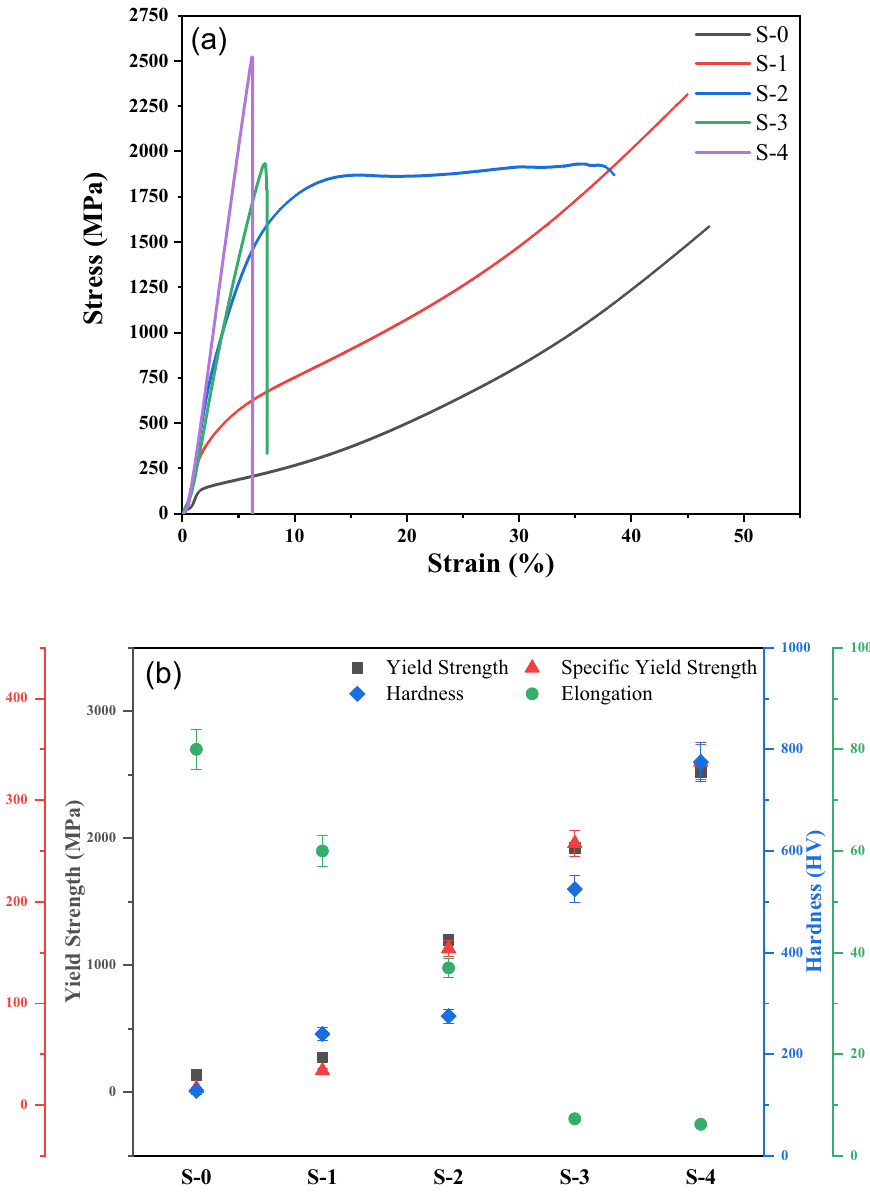
Figure 9. ( a ) Compressive stress–strain curves and ( b ) scatter plot showing specific yield strength, yield strength, hardness and elongation. Note that data for only samples S-0 to S-4 are shown, as samples S-5 and S-6 contained obvious casting defects.